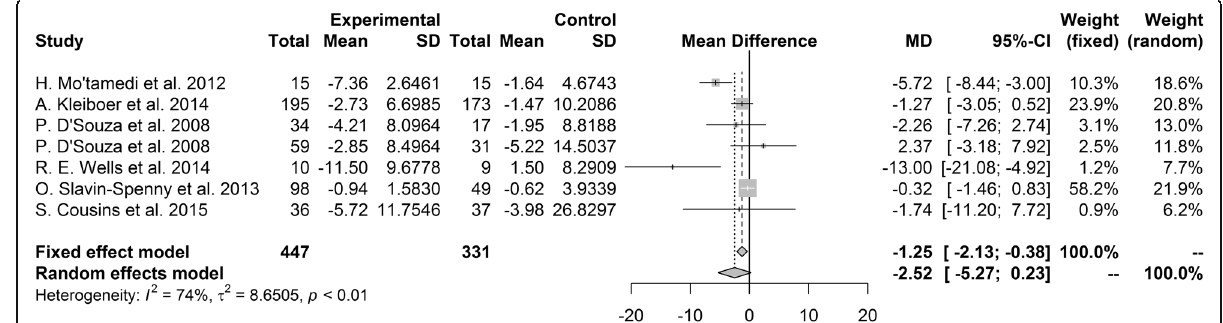
Fig. 6 Forest plot of migraine disability